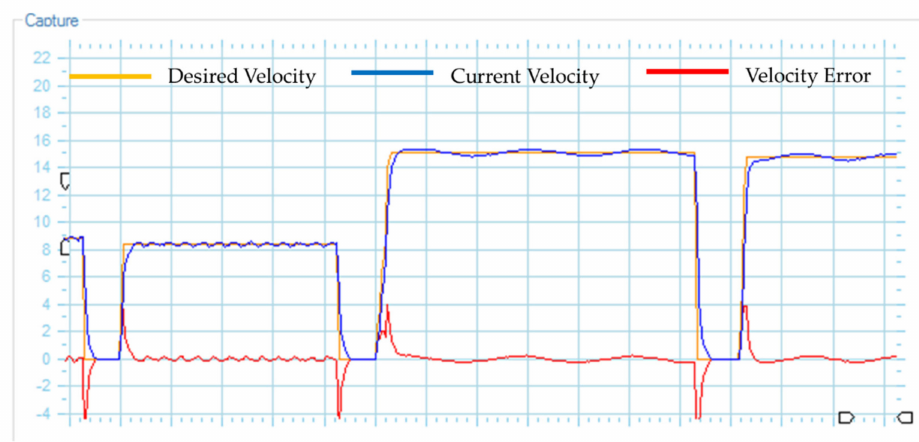
Figure 9. Right motor velocity of the standing wheelchair with a Proportional Integral Deriva- tive